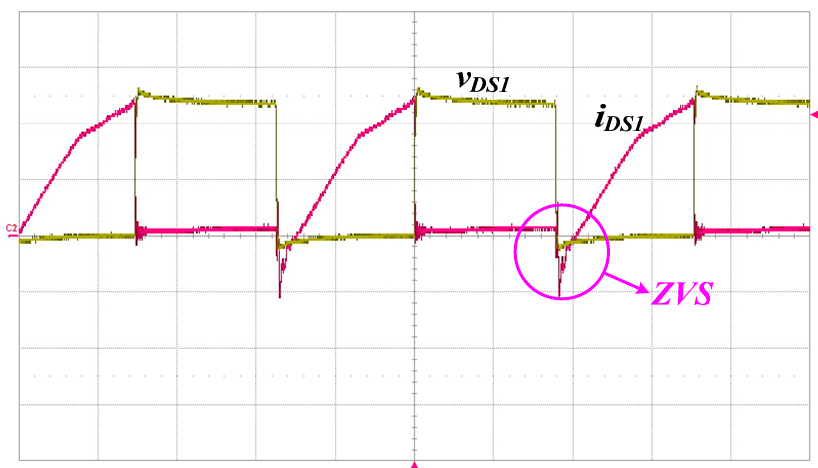
Figure 9. Measured switch voltage v DS 1 (200 V/div) and current i DS 1 (2 A/div); time scale: 5 μ s/div.